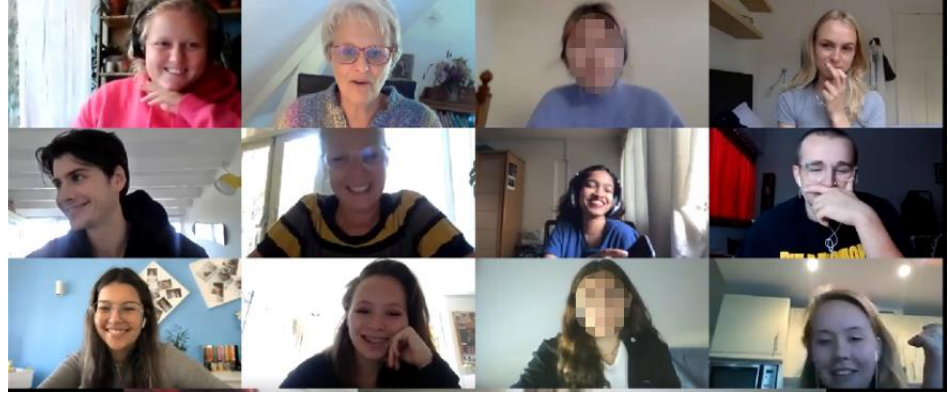
Figure 7. Data 7 : Laughter and play.